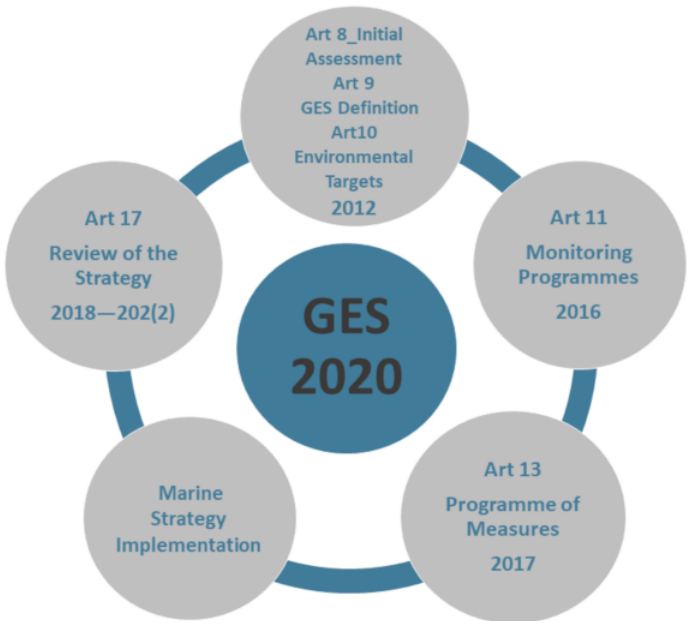
Figure 1. The 1st MSFD implementation cycle in Greece (modified from